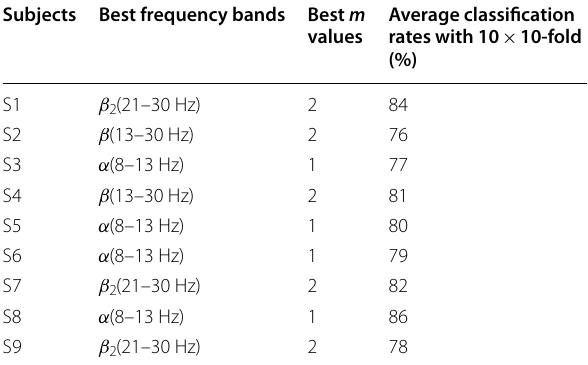
Table 2 Summarization of the best parameters for all subjects on Dataset B